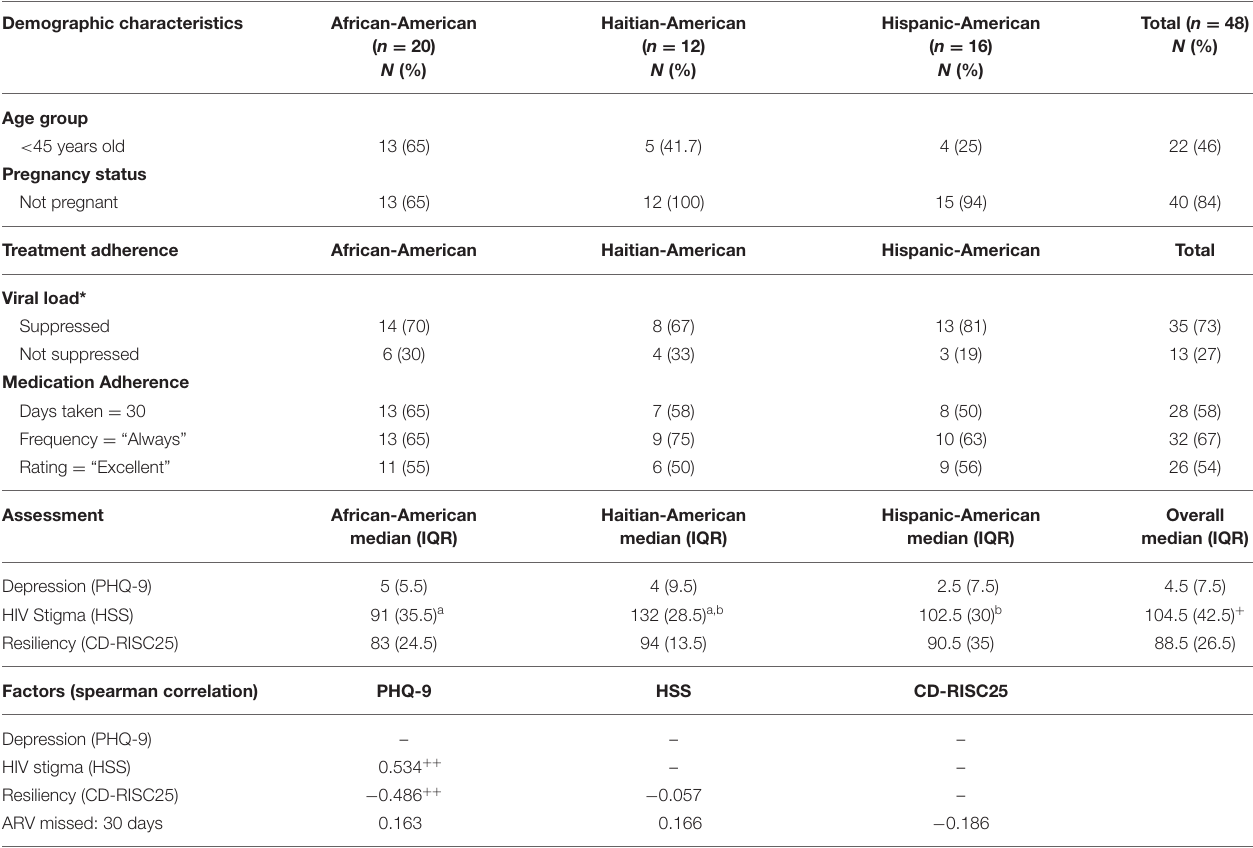
TABLE 2 | Demographic profile and baseline assessments by ethnicity, and correlation of assessments. Demographic